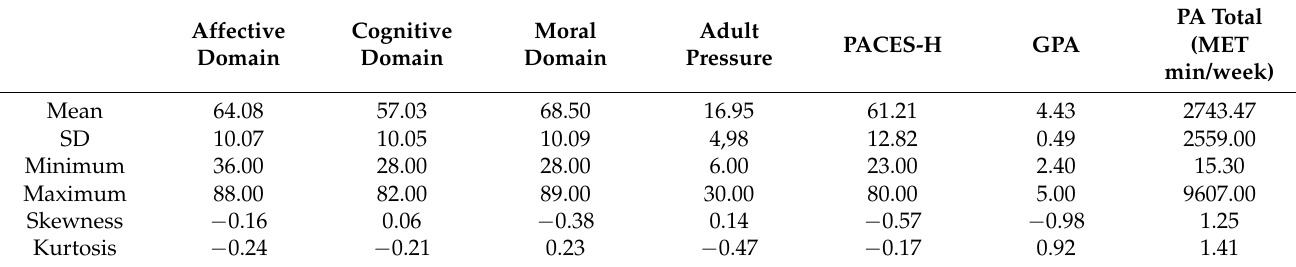
Table 2. Descriptive statistics of the study